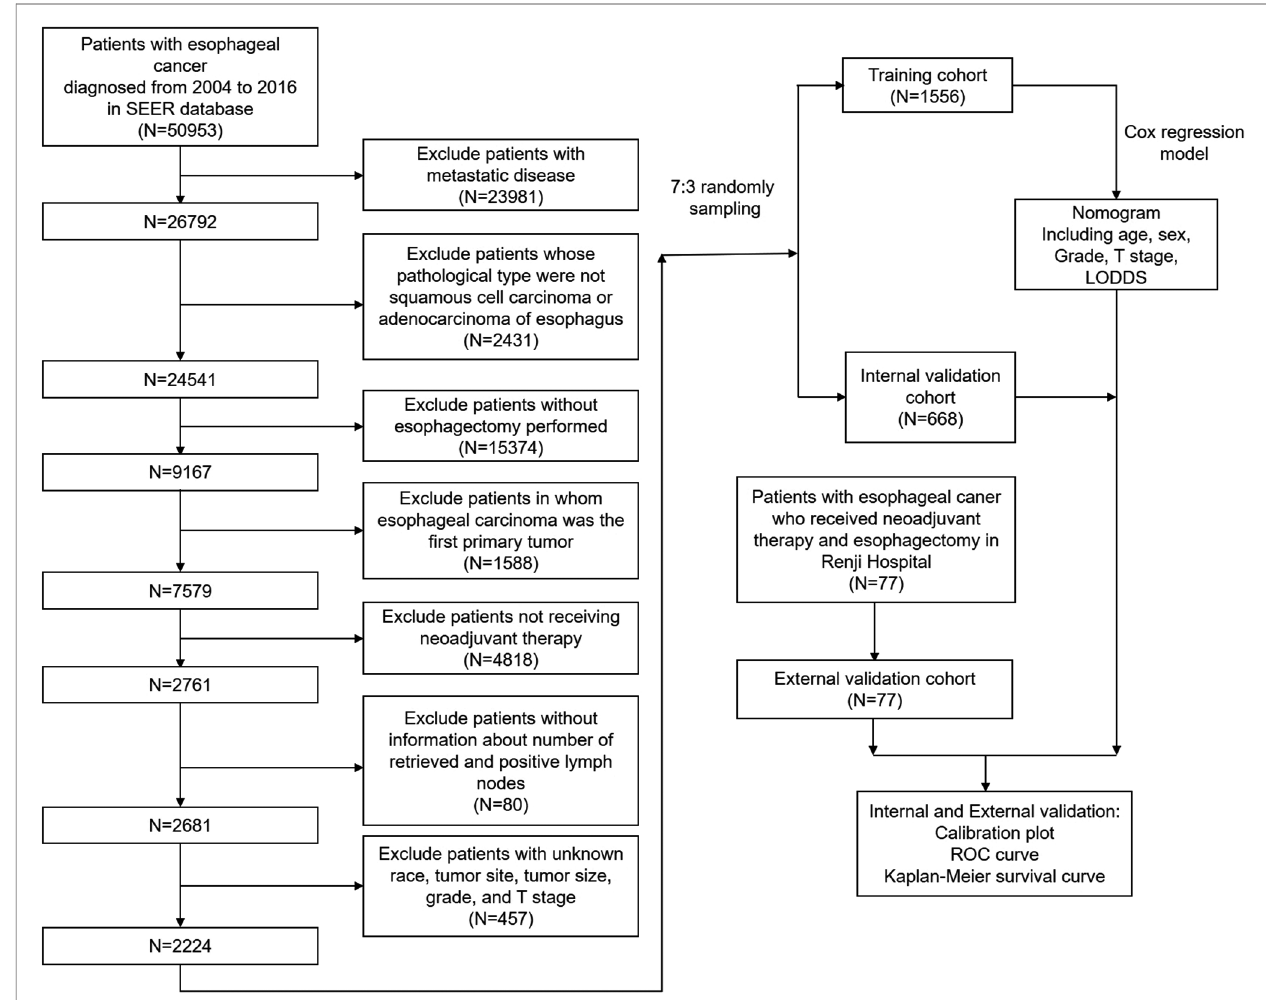
FIGURE 1 | Flowchart of patients screening and study